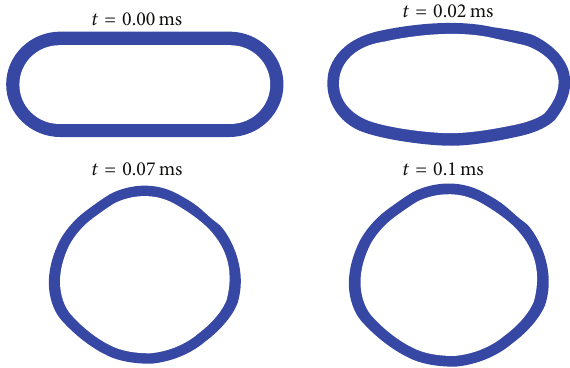
Figure 7: Expanding tube distortions (explosive load